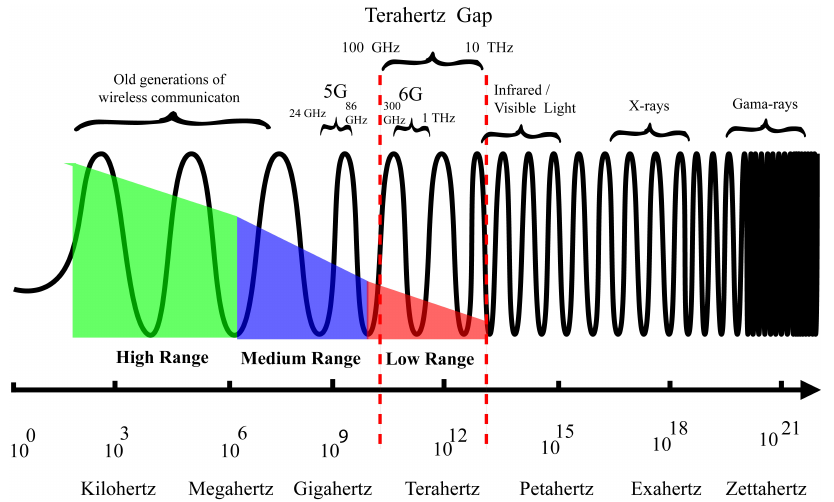
Figure 1. Electromagnetic waves spectrum and